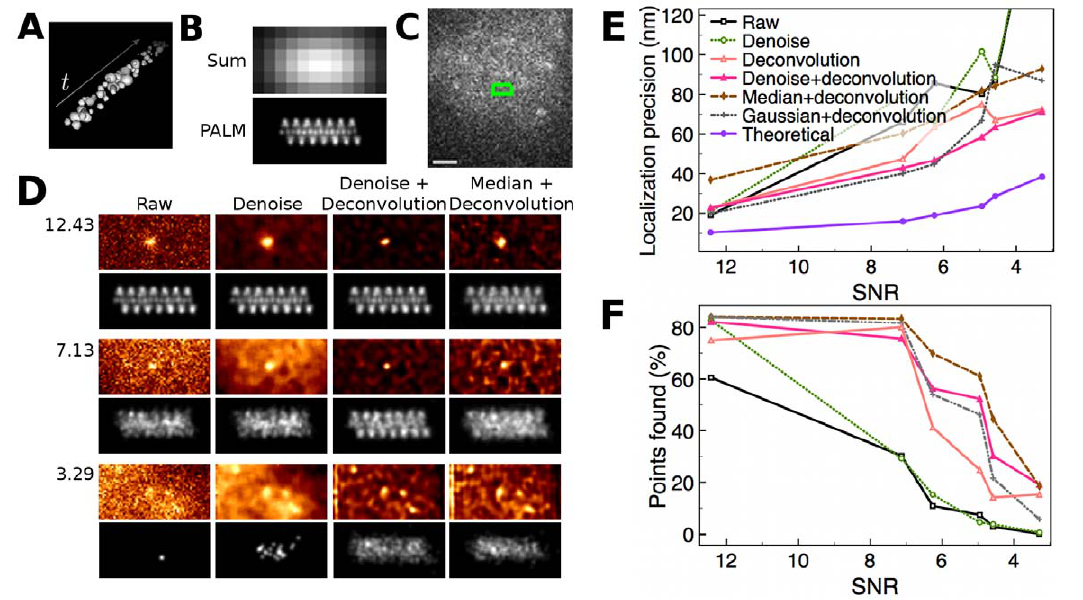
Figure 2. A Simulation of PALM Reconstruction in Relation to the Noise. (A) Points making up a simulated helix with a pitch of 80 nm is confined in a 5,600 nm 6 160 nm 6 160 nm space, and randomly scattered over 10,000 time frames. This is convolved with a real point-spread function (PSF) to imitate real microscopic diffraction spots. The central cross section was used as a raw PALM image. (B) ‘‘Sum’’ is the summation of all diffraction limited raw images, and ‘‘PALM’’ is the PALM reconstruction. (C) Acquired noise image with SD of 1.67 photons (SNR 7.13). The green box shows where the helix is to be embedded. Bar is 1.0 m m. (D) Images of different noise levels were added to the simulated raw image. Shown here are results for three noise levels corresponding to SNRs of 12.43, 7.13, and 3.29. For each noise level, shown in color are a raw image with a representative peak and the same image denoised, denoised and then deconvolved, and median-filtered and then deconvolved. Shown in grayscale are the PALM reconstructions corresponding to each of the 4 circumstances. The pixel size of the PALM reconstruction images is 1/6 of that of the raw images. (E) One-dimensional localization precision as full width of half maximum (FWHM) of the error distribution (see Fig S2A). Localization precision from the raw and the denoised images is outside of plot area at SNR 3.29 due to the unavailability of enough number of points to calculate FWHM. (F) Point finding efficiency. The graph color code in (E) applies to this plot as well.